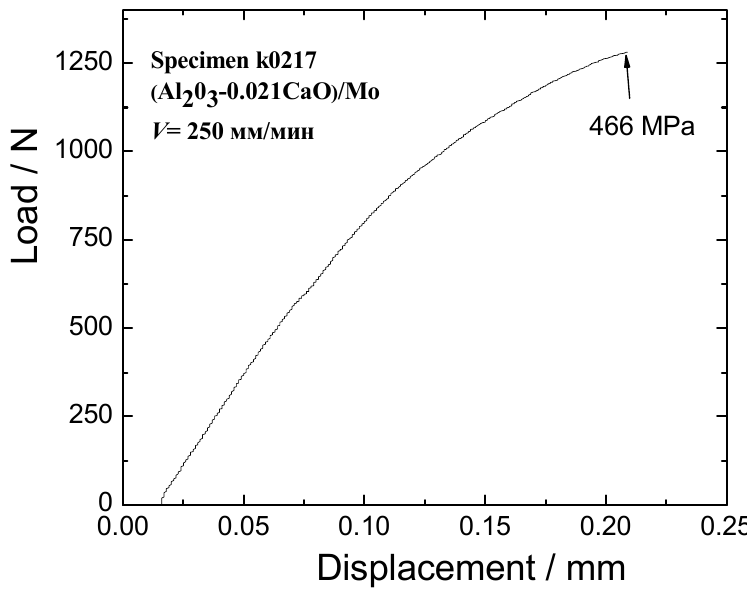
Figure 9. The load/displacement curve obtained in the three-point bending of a composite specimen.